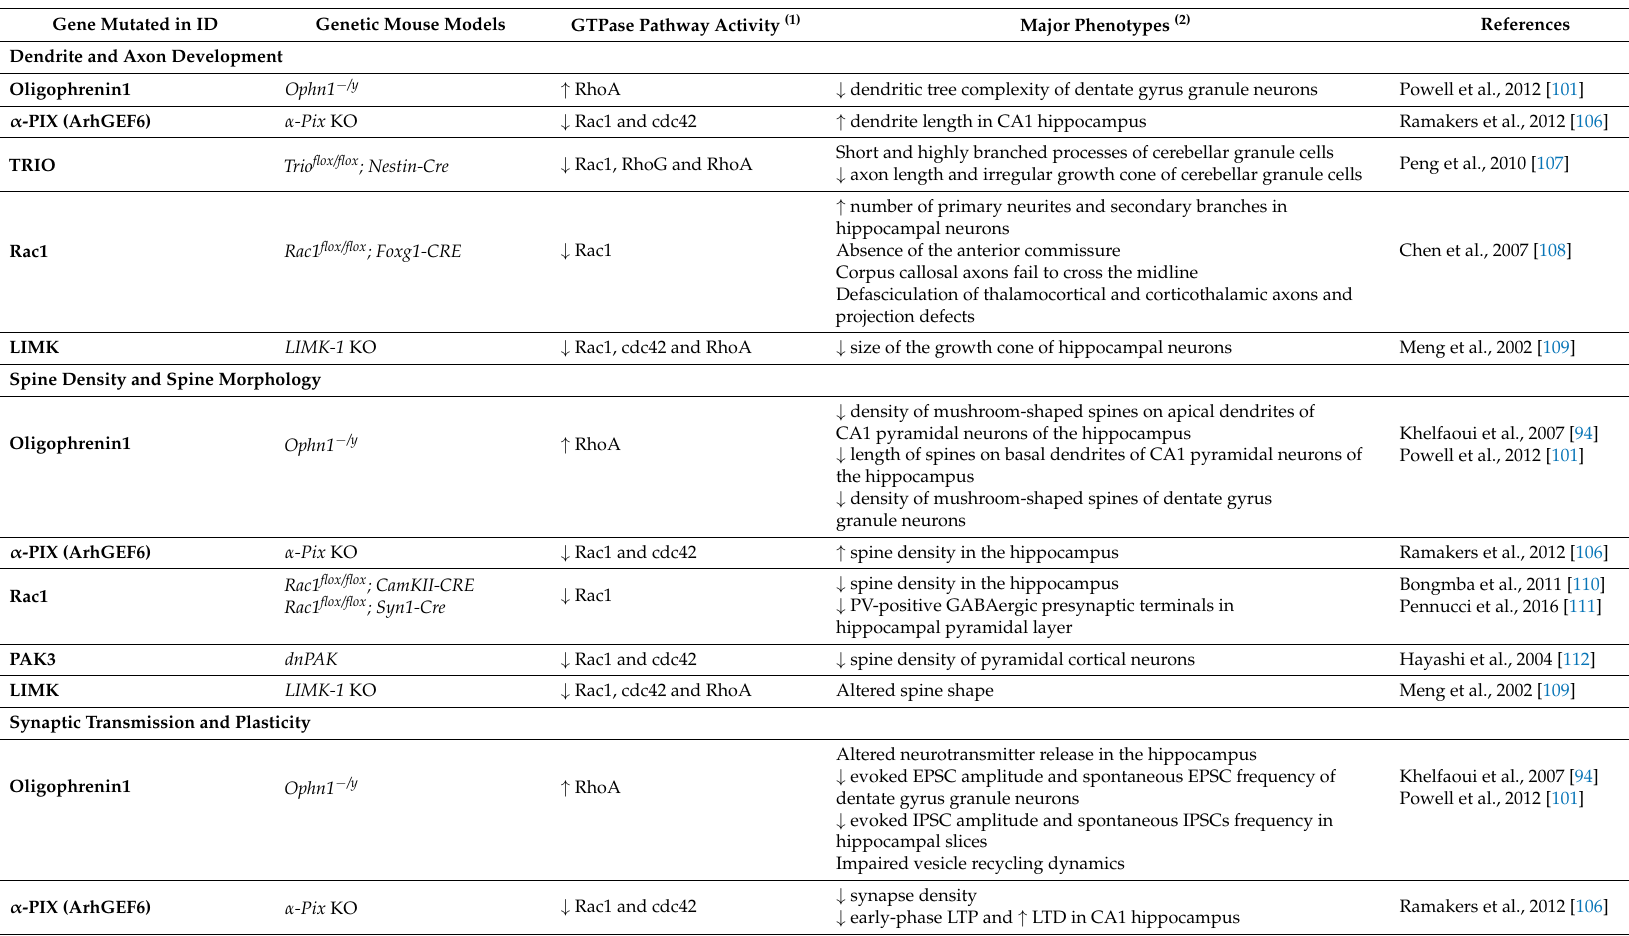
Table 1. The main cellular phenotypes of ID mouse models, related to altered GTPase functions, focusing on dendrites, axon, spine and synaptic